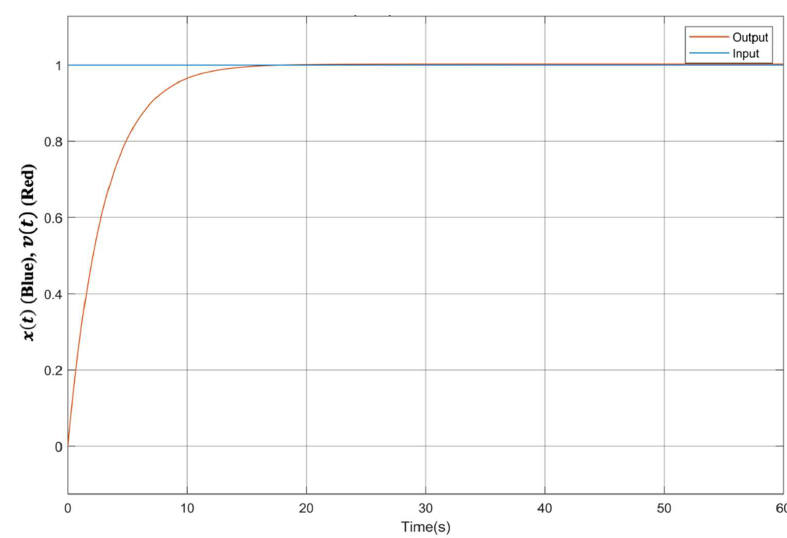
Figure 11. Response to Step Input with Transform and Control.